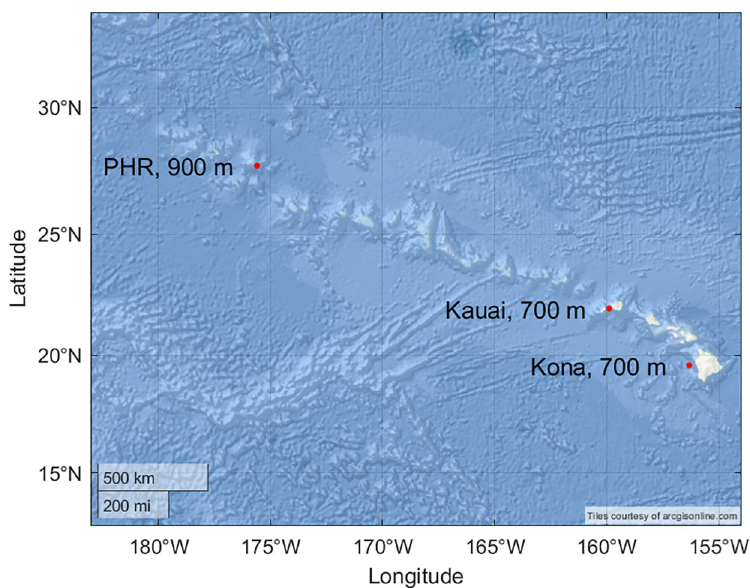
Fig 1. Map of recording locations. Map showing the latitude-longitude locations of the Kona, Kaua‘i, and PHR sites. Location and depth of each site was averaged among deployments from that site. Basemap image is the intellectual property of Esri and is used herein with permission. Copyright © 2022 Esri and its licensors. All rights reserved.